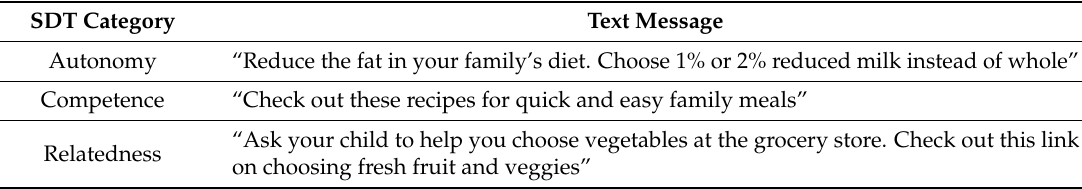
Table 3. Sample dietary messages based on self-determination theory.